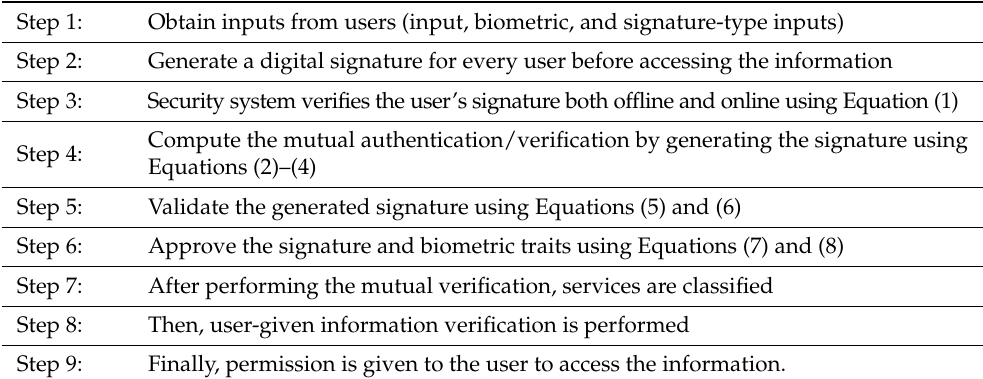
Table 1. Step-by-step procedure of the DSVT.